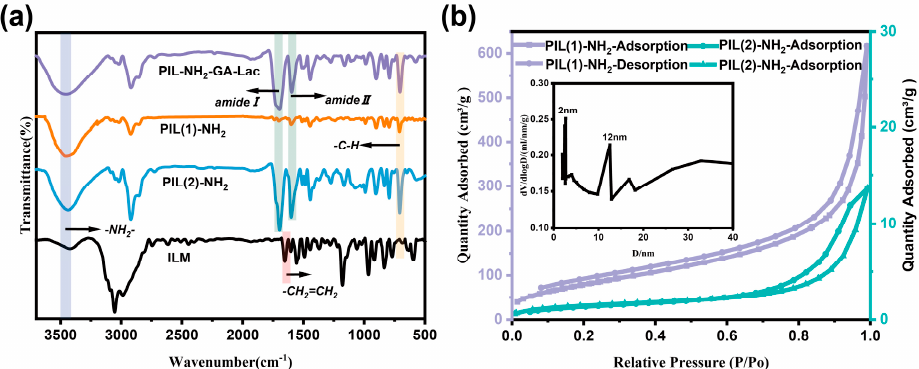
Figure 2. FTIR spectra of PIL–NH 2 and PIL–NH 2 –GA–Lac ( a ). Nitrogen adsorption–desorption isotherms and BJH pore size distributions of PIL–NH 2 ( b ).